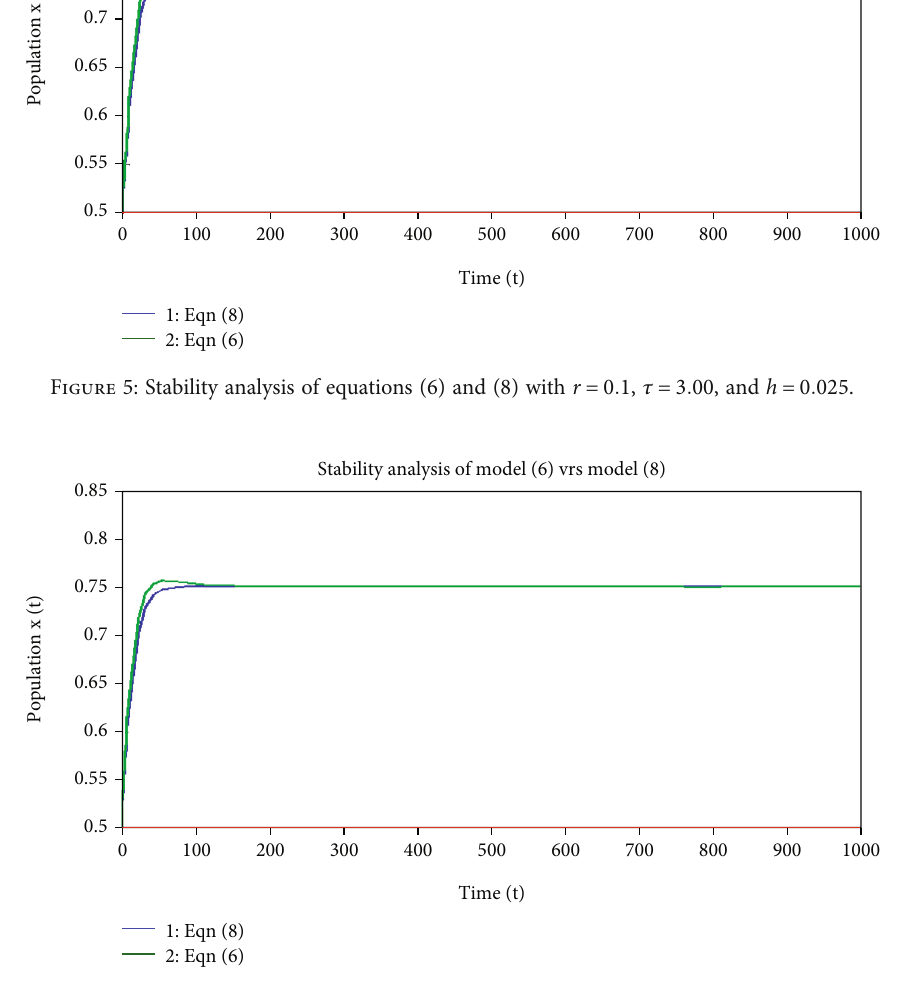
Figure 6: Stability analysis of equations (6) and (8) with r = 0 : 1 , τ = 3 : 00, and h = 0 : 025